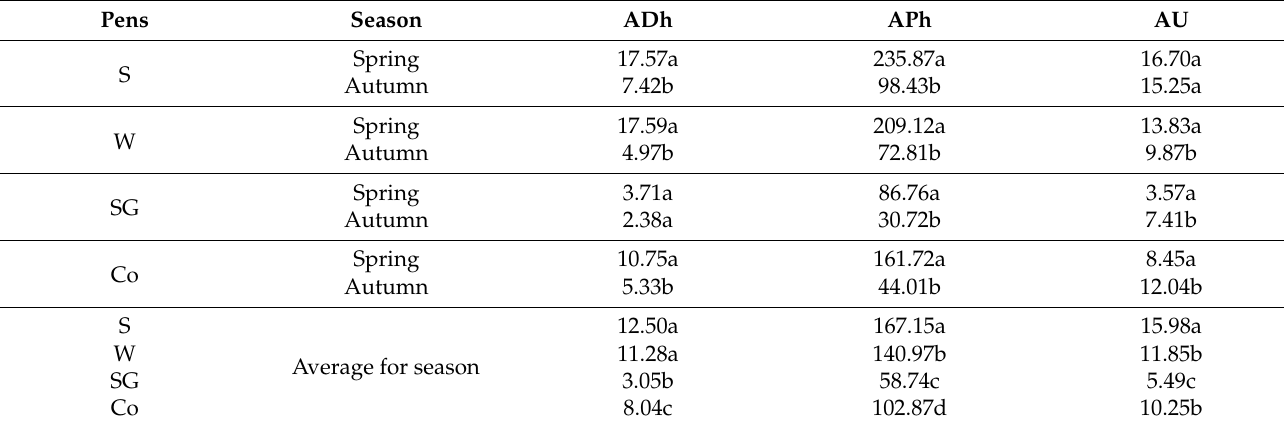
Table 5. Enzymatic activity of soils.